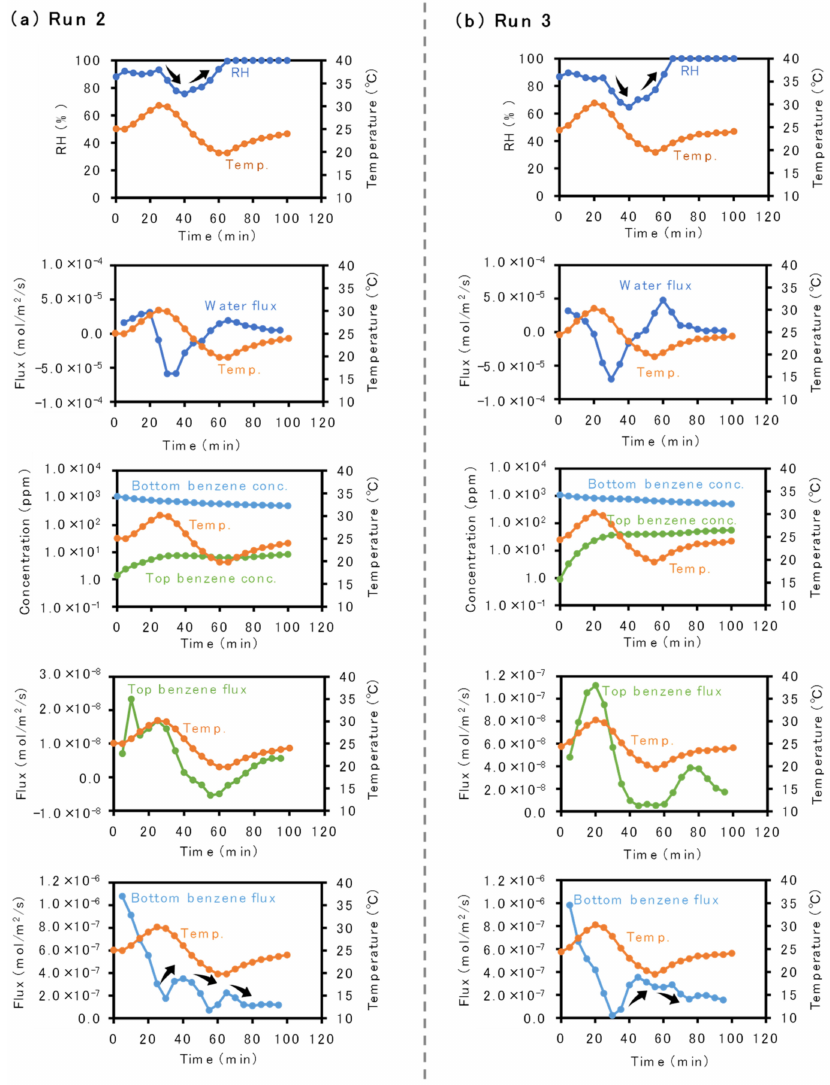
Figure 5. Changes in RH and corresponding water flux, top and bottom benzene concentrations, and corresponding top and bottom benzene fluxes in the dynamic temperature experiments Run 2 and Run 3, respectively, with ( a ) coarser-grained silica sand and ( b ) finer-grained silica